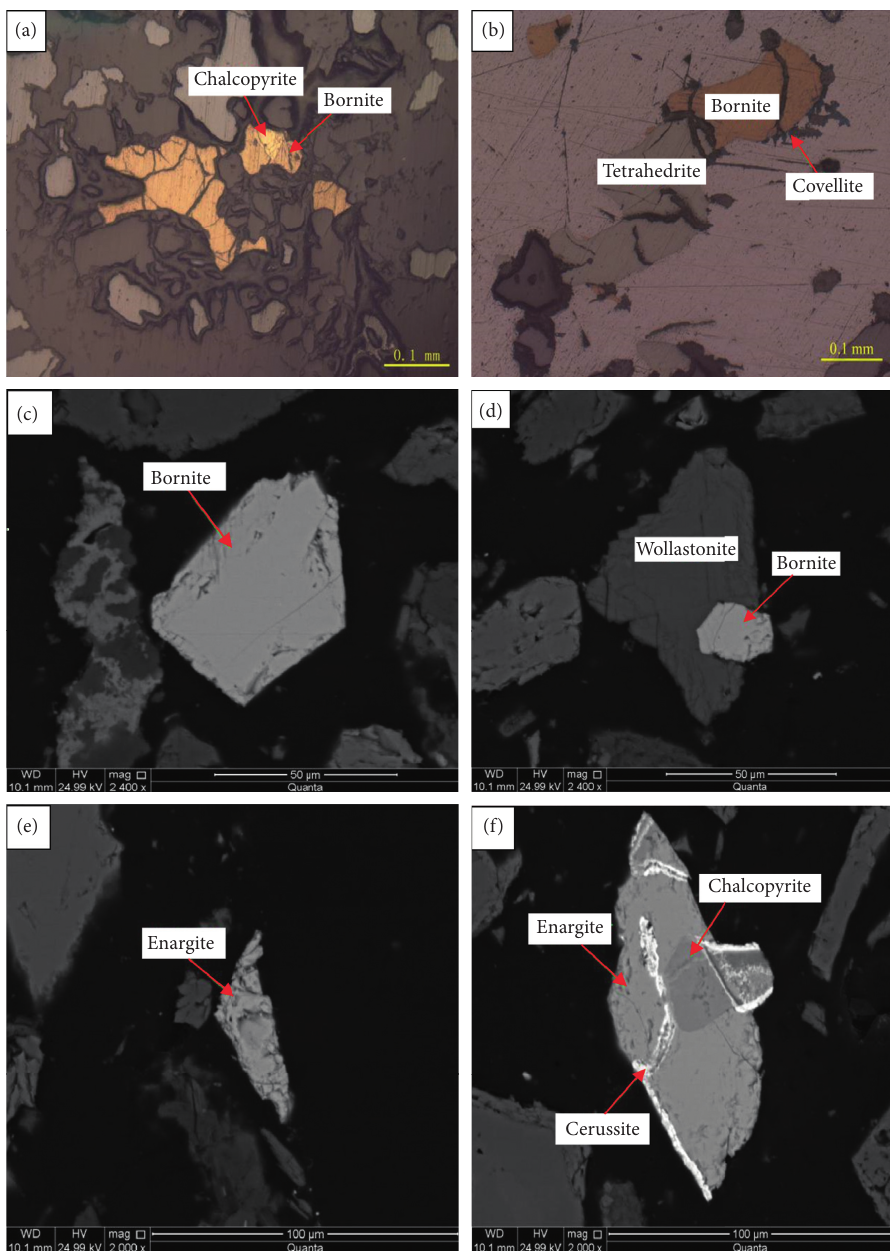
Figure 4: Embedded characteristics of bornite and